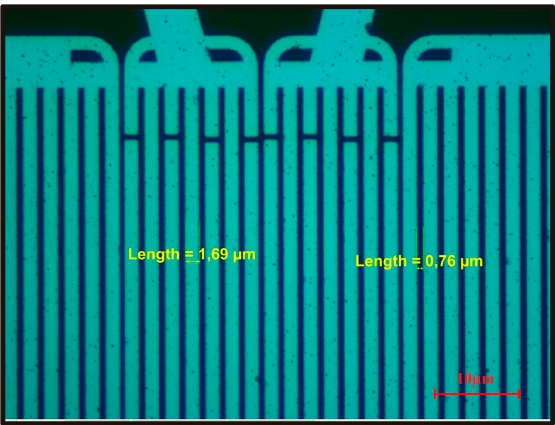
Figure 2. Optical microscope image of two port SAW device showing the IDT electrode width, i.e., 1.69 µ m and spacing, i.e., 0.76 µ m between two consecutive